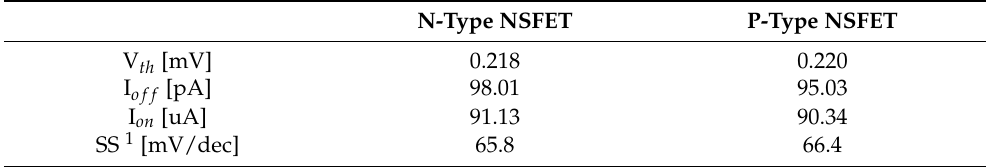
Table 1. The electrical characteristics obtained using a TCAD simulation.